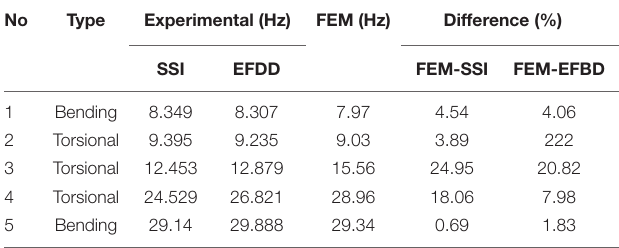
TABLE 5 | Comparison of modal frequencies.